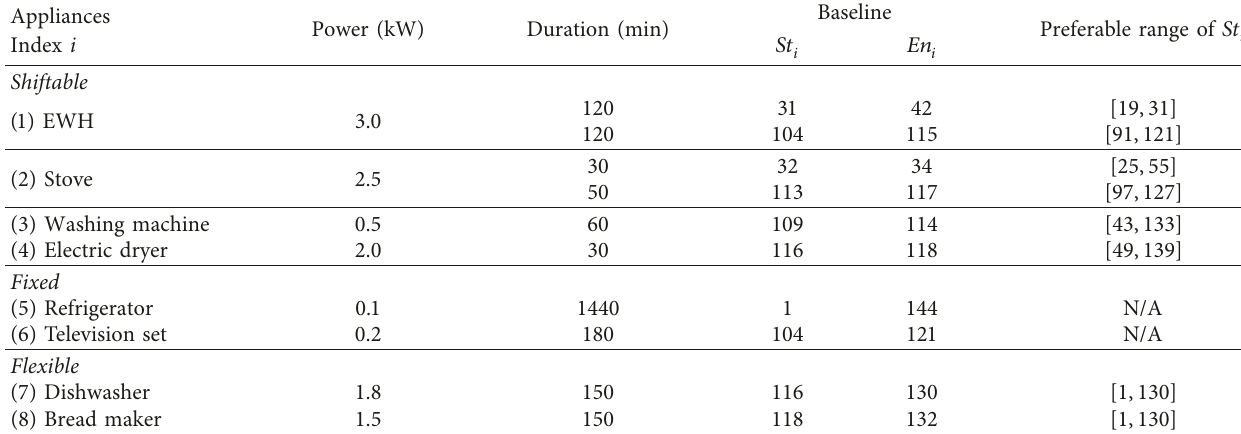
Table 1: Typical usage profiles and baseline time schedules.